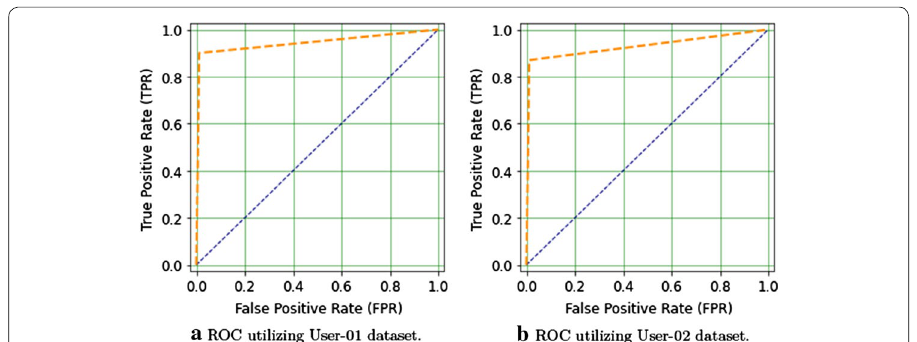
Fig. 8 ROC values of contextual feature selection based random forest model considering weighted average of activity classes